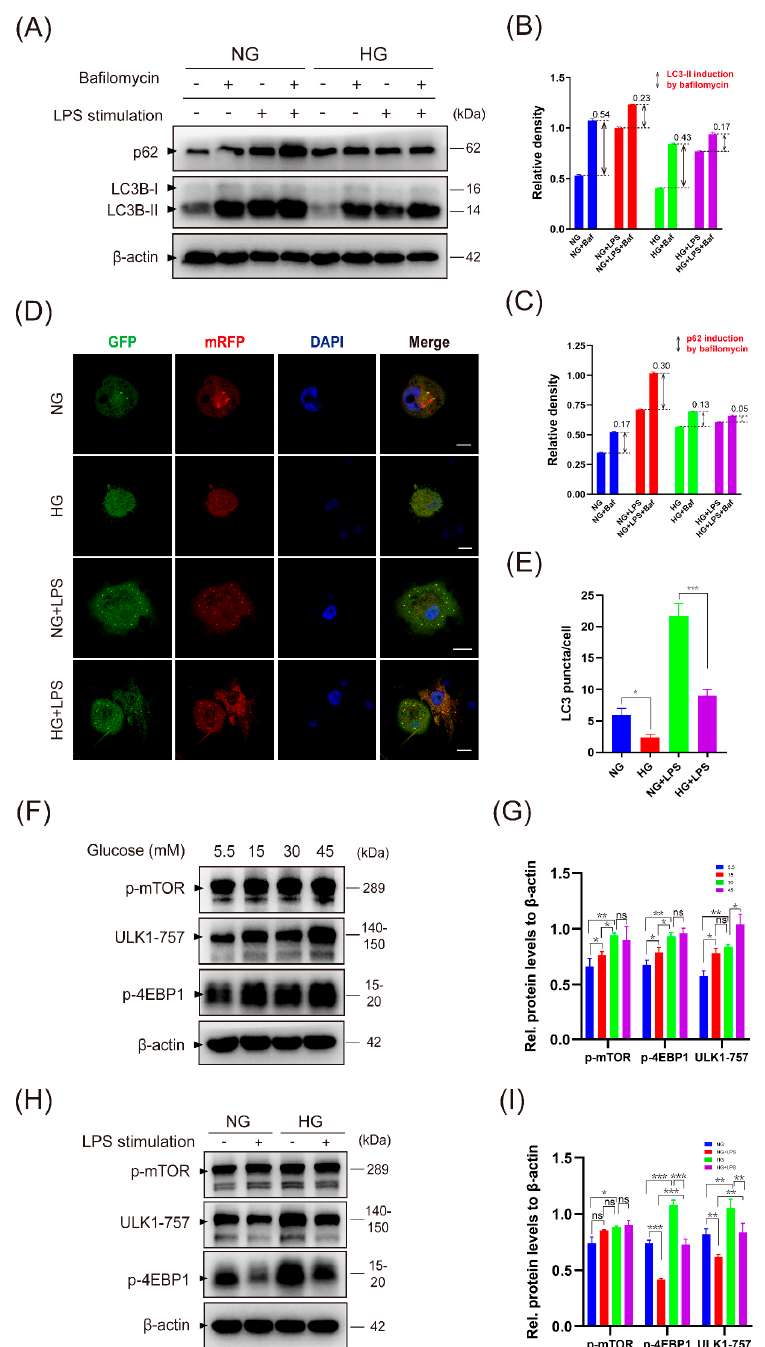
Figure 5. HG activates the mTOR pathway and decreases autophagic flux in THP-1 macrophages. ( A – C ) THP-1 macrophages were cultivated in NG or HG medium for 24 h and were then stimulated with or without LPS (1 µ g/mL) for 24 h. For the last 2 h, cells were treated with or without bafilomycin (Baf, 100 nM). LC3B-II and p62 protein levels were measured by Western blot and quantified using ImageJ analysis. LC3B-II and p62 induction by bafilomycin demonstrates autophagic flux. ( D , E ) Macrophages were transfected with mRFP-GFP-LC3 adenovirus for 6 h (MOI = 200) and were then stimulated as illustrated above. ( D ) Representative microscopic images of LC3 puncta (scale bar: 10 μ m). ( E ) Quantification based on counting LC3 puncta per cell. ( F – I ) Detection of mTOR pathway expression of THP-1 macrophages stimulated as in Figure 3A ( F , G ) and Figure 3C ( H , I ). Values are mean ± SD. * p < 0.05. ** p < 0.01. *** p < 0.001.